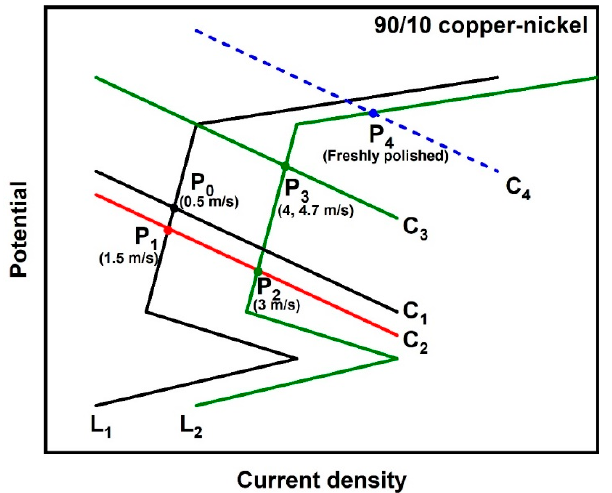
Figure 9. An ideal schematic mechanism of the corrosion process of the 90/10 copper–nickel tube in NaCl solution at different flow velocities.